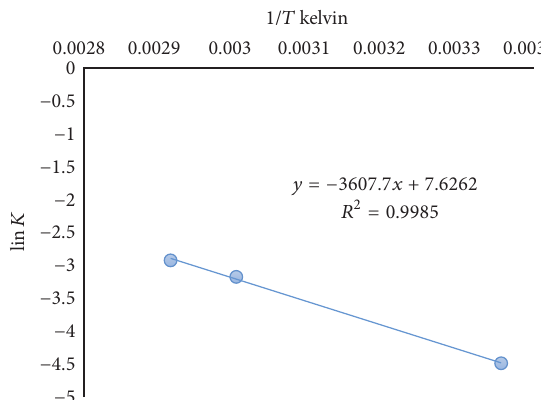
Figure 7: Arrhenius plot for degradation of DD at 40 ∘ C and 50 ∘